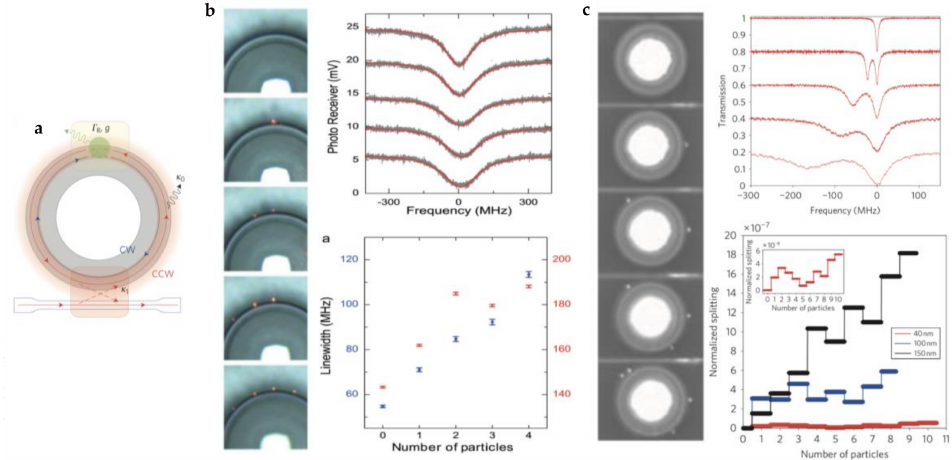
Figure 4. ( a ) Schematic of the microtoroid resonator in the presence of a nanoparticle. A portion g of the light scattered by the nanoparticle is coupled back into the resonator, allowing both CW and CCW propagating light in the cavity. Reproduced with permission from [21]. Copyright (2010) Nature Publishing Group. ( b ) Transmission spectra and the corresponding optical images attachment of four successive individual nanoparticles. The normalized spectra are vertically shifted for clarity. Normalized mode splitting versus single nanoparticle binding events are shown, with the inset representing the enlarged plot for nanoparticles at R = 40 nm. Different sizes of nanoparticles are also examined, and represented by different colors in the figure. Reproduced with permission from [21]. Copyright (2010). Nature Publishing Group. ( c ) Mode broadening induced by four successive polystyrene nanoparticles at R = 70 nm. Linewidths of the two different WSG sensors in the experiment are shown in the lower diagram. Reproduced with permission from [120].